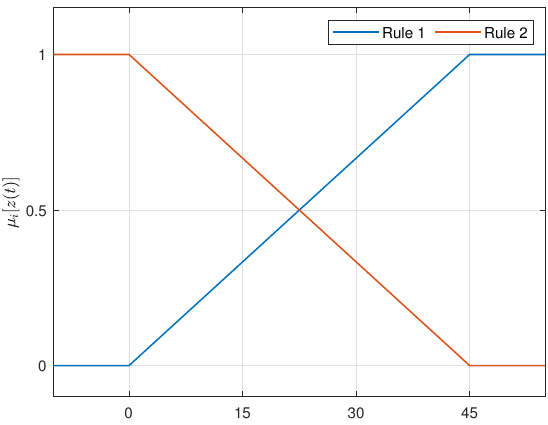
Figure 3. Fuzzy membership function. Table 1. Parameter of the flexible